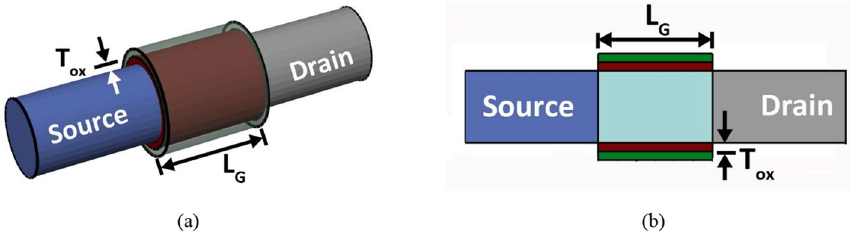
Figure 1. EOEC eGAA TFET structure: ( a ) 3D view, ( b ) cross-sectional view.